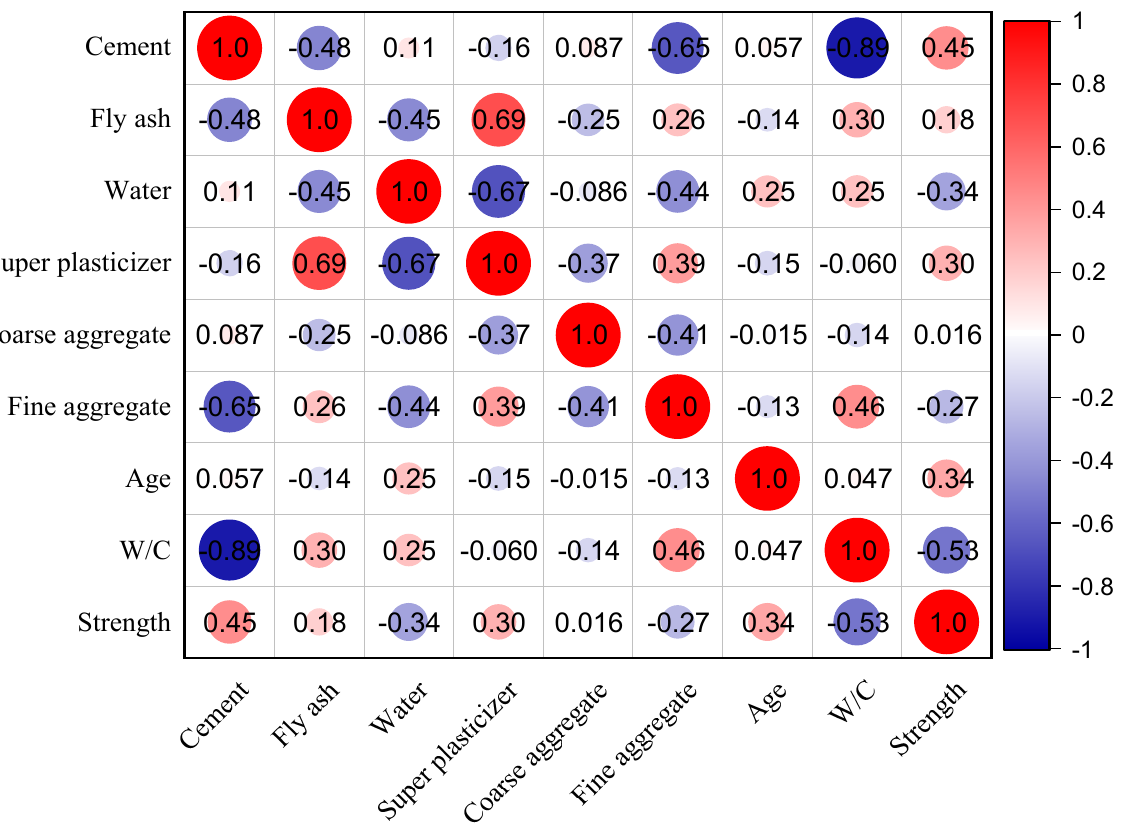
Figure 5. Pearson’s correlation coefficient between any two variables. Table 1. Variable statistical characteristics.